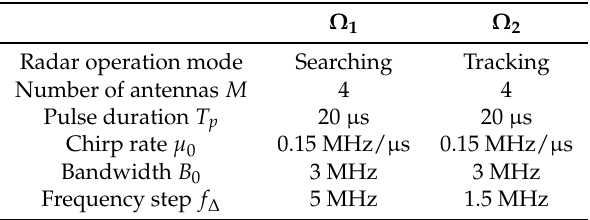
Table 1. Parameters of Orthogonal Frequency Division Multi-Linear Frequency Modulation (OFDM-LFM)